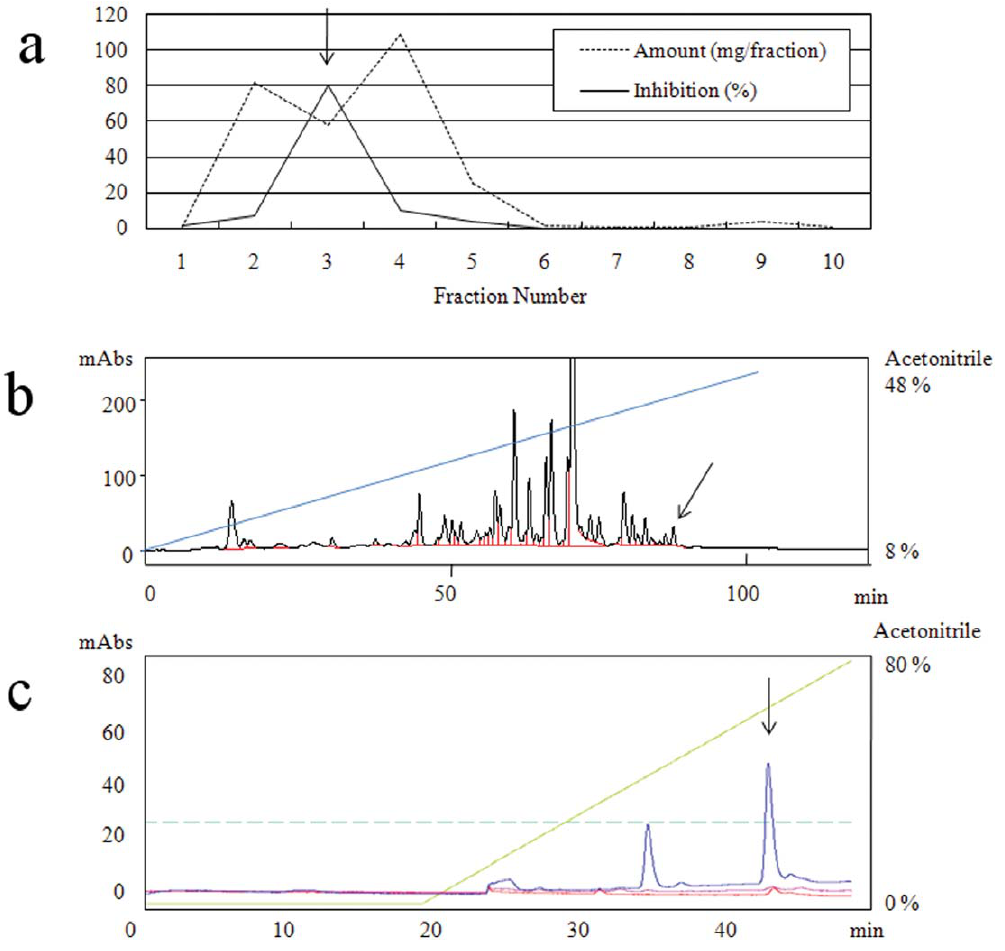
Figure 1. Purification of a serotonin transporter (SERT) inhibitor from a chicken essence beverage. (A) Sephadex LH-20 column chromatography of the diethyl ether extract. Every 80 ml of elution was collected from a Sephadex LH-20 column. Dried weight (dotted line) and SERT inhibitory activity (solid line) are shown. (B) Develosil ODS-HG-5 column chromatography of the fraction 3 from (A). The column was eluted with a linear gradient of 8–48% acetonitrile at a flow rate of 6 ml/min (blue line). The black line represents the relative absorbance at 215 nm. The red line represents peak fractionation. The active peak shown by the arrow was evaporated and dissolved in distilled water. (C) SOURCE 15 RPC column chromatography of the active fraction in (D). The column was eluted with a linear gradient of 0–80% acetonitrile at a flow rate 0.5 ml/min (green line). The blue, pink, and red lines represent the relative absorbance at 215, 240, and 280 nm, respectively. Dotted blue-green line represents 25 milliabsorbance (mAbs). The active peak is shown by the arrow.